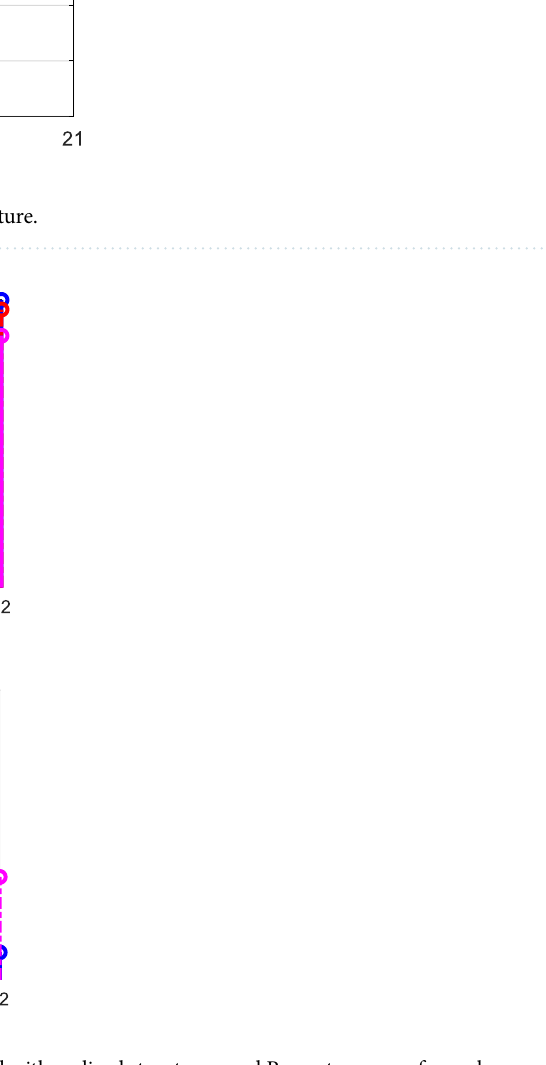
Figure 26. Calculated Fresnel zones compared with realized structures, and Percentage error for each